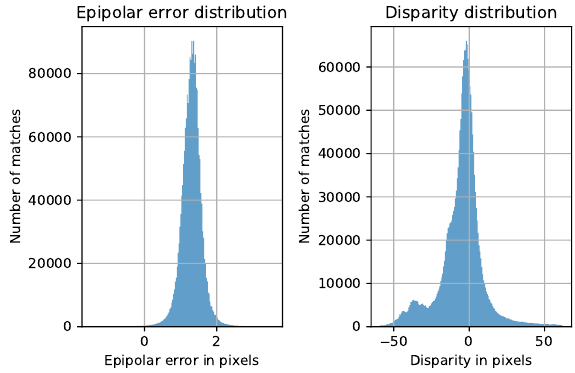
Figure 4. Detail of left epipolar image (left), right epipolar image before correction (center) and right epipolar image after correction (right), from the PHR Mont-Blanc case (see section 4.1). The horizontal red line helps noticing the 1.39 pixel epipolar error that we are able to perfectly re-align.